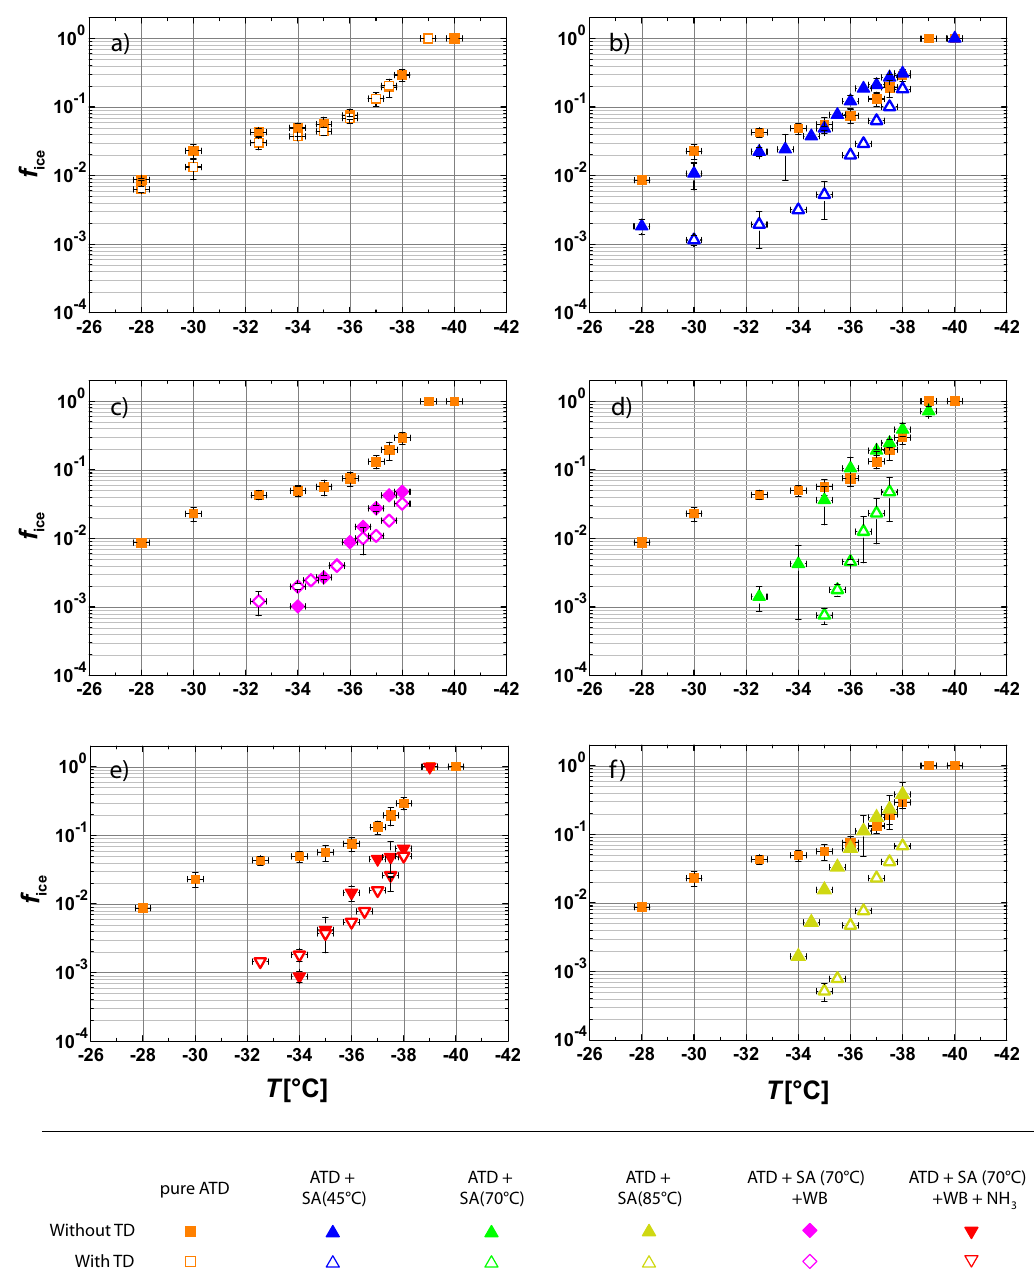
Fig. 4. Immersion freezing behavior of all types of examined particles. (a) pure ATD (orange squares), (b) ATD + SA(45 ◦ C) (blue triangles), (c) ATD + SA(70 ◦ C) + WB (pink diamonds), (d) ATD + SA(70 ◦ C) (green triangles), (e) ATD + SA(70 ◦ C) + WB + NH 3 (upside down red triangles) and panel (f) ATD + SA(85 ◦ C) (dark yellow triangles). Open and filled symbols represent particles that were and were not thermally treated, respectively. For comparison the ice fractions for pure ATD are inserted in each